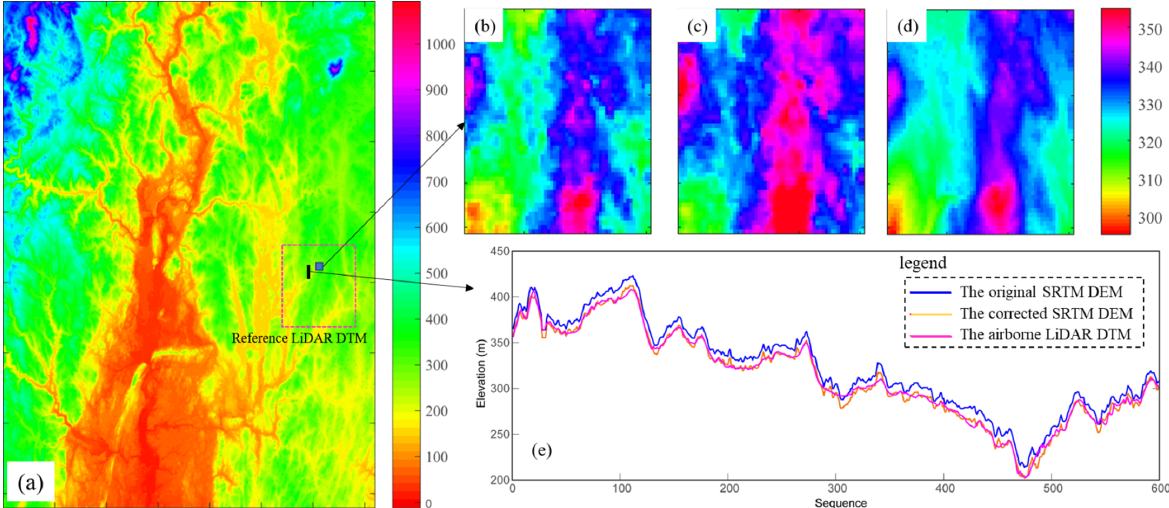
Figure 5. Qualitative evaluation of the corrected SRTM DEM. ( a ) The corrected SRTM DEM; partially enlarged views of ( b ) the corrected SRTM DEM, ( c ) the original SRTM DEM and ( d ) the reference LiDAR DTM; ( e ) profiles compare the terrains of the corrected SRTM DEM, the original SRTM DEM, and the reference LiDAR DTM.